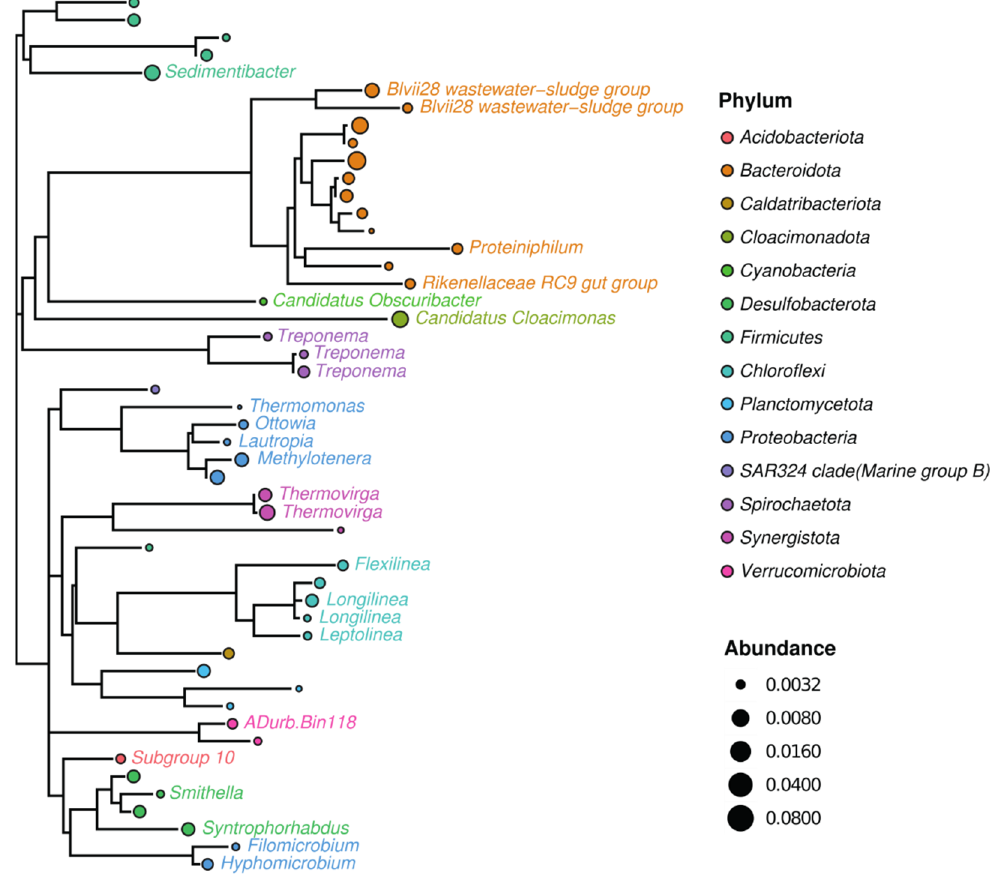
Figure 3. Phylogenetic tree, showing genetic relationships of sewage sludge community used for inoculation of all MECs. Only 50 most abundant representatives are shown. Circle color represents phylum taxa, and circle size corresponds to their relative abundance. The tree is labeled by color-coded representatives identified in the taxa of the genus.